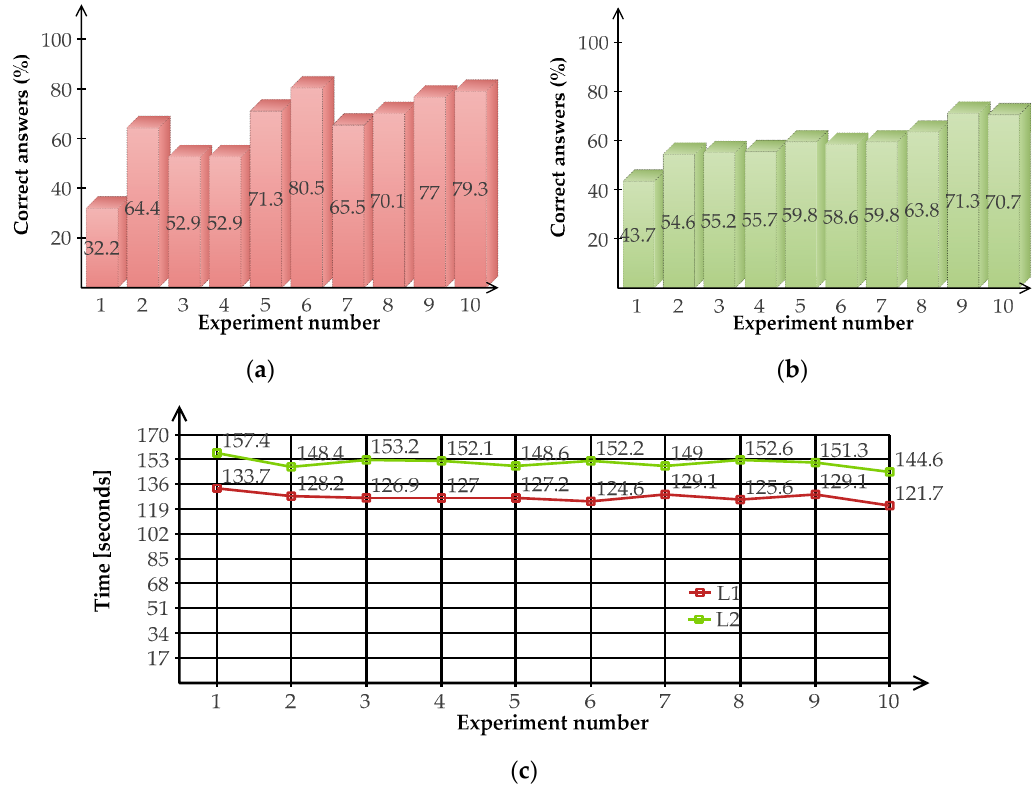
Figure 13. Results of the immersive virtual reality application in the user-controlled mode of the game: ( a ) Success rate at the basic level; ( b ) Success rate at the advanced level; ( c ) Maze completion times.